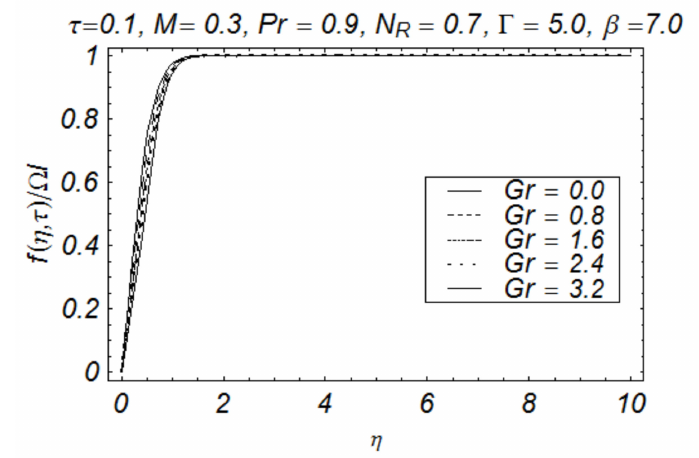
Figure 6. Indication of Gr on primal velocity.